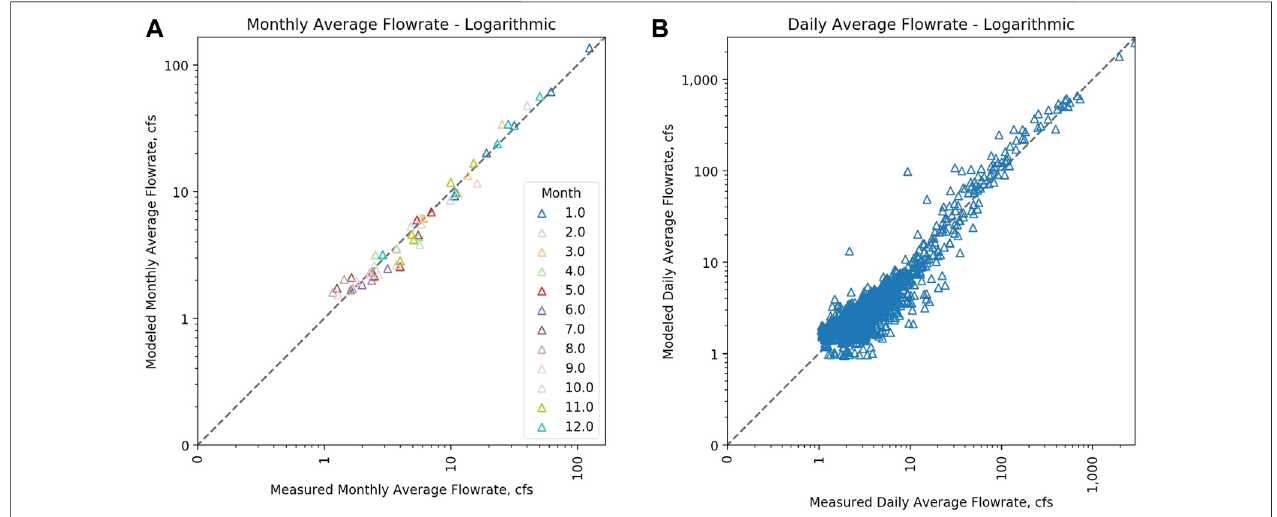
FIGURE3| Comparisonofmonthly (A) anddailyaverage (B) simulatedstream fl owtoobservedstream fl owatthelowerAlisoCreekgagebetween1October2014 and 20 May 2019.